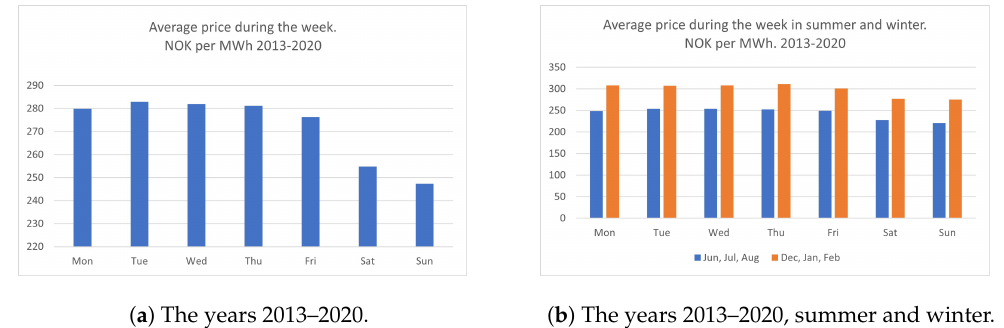
Figure 7. Average price per MWh measured in NOK in the period 2013–2020 over the entire year ( a ) and average price per MWh measured in NOK in the period 2013–2020 in the summer months (June, July and August) and in the winter months (December, January and February) ( b ).